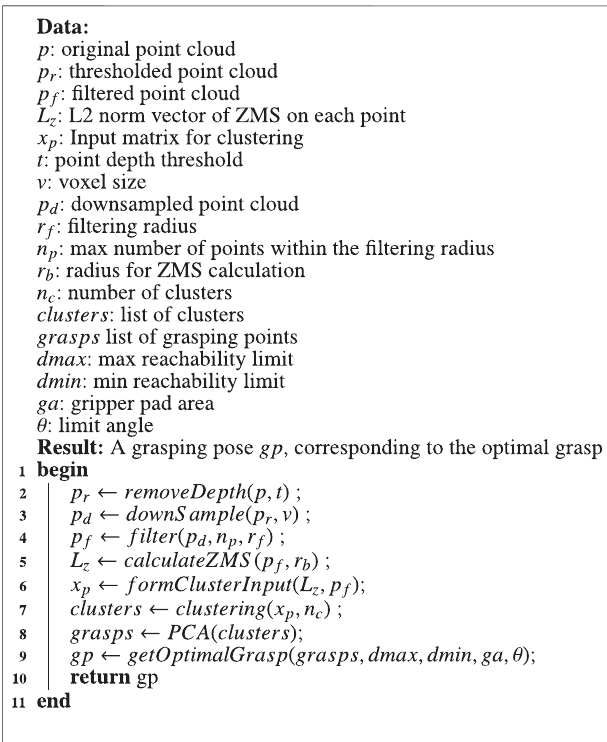
Algorithm 1: An outline of the steps used in the grasping algorithm (Mavrakis and Gao,